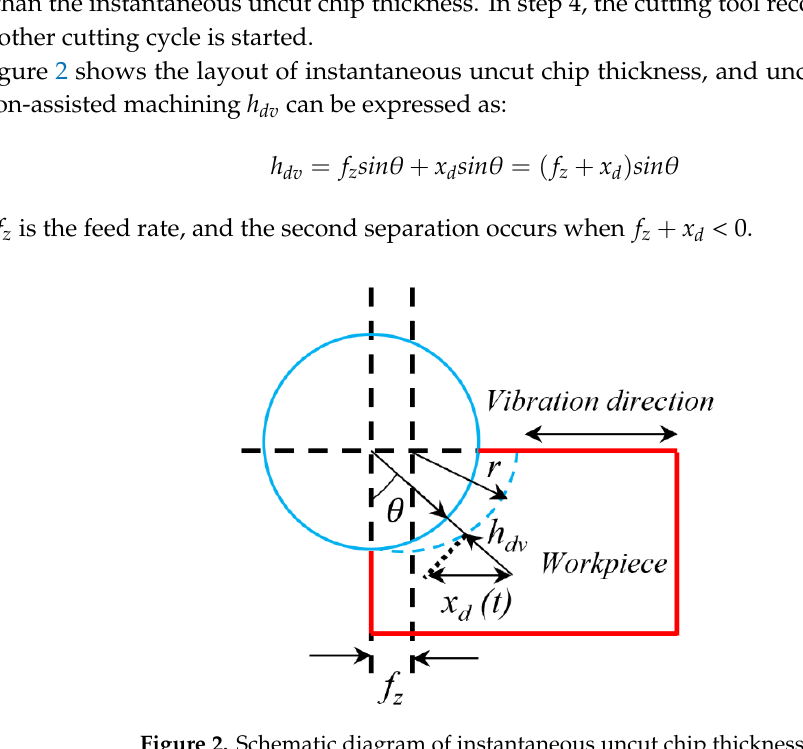
Figure 2. Schematic diagram of instantaneous uncut chip thickness.